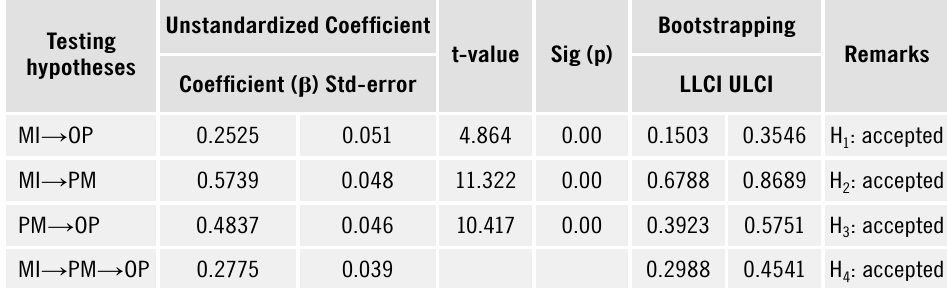
Table 5. Hypotheses